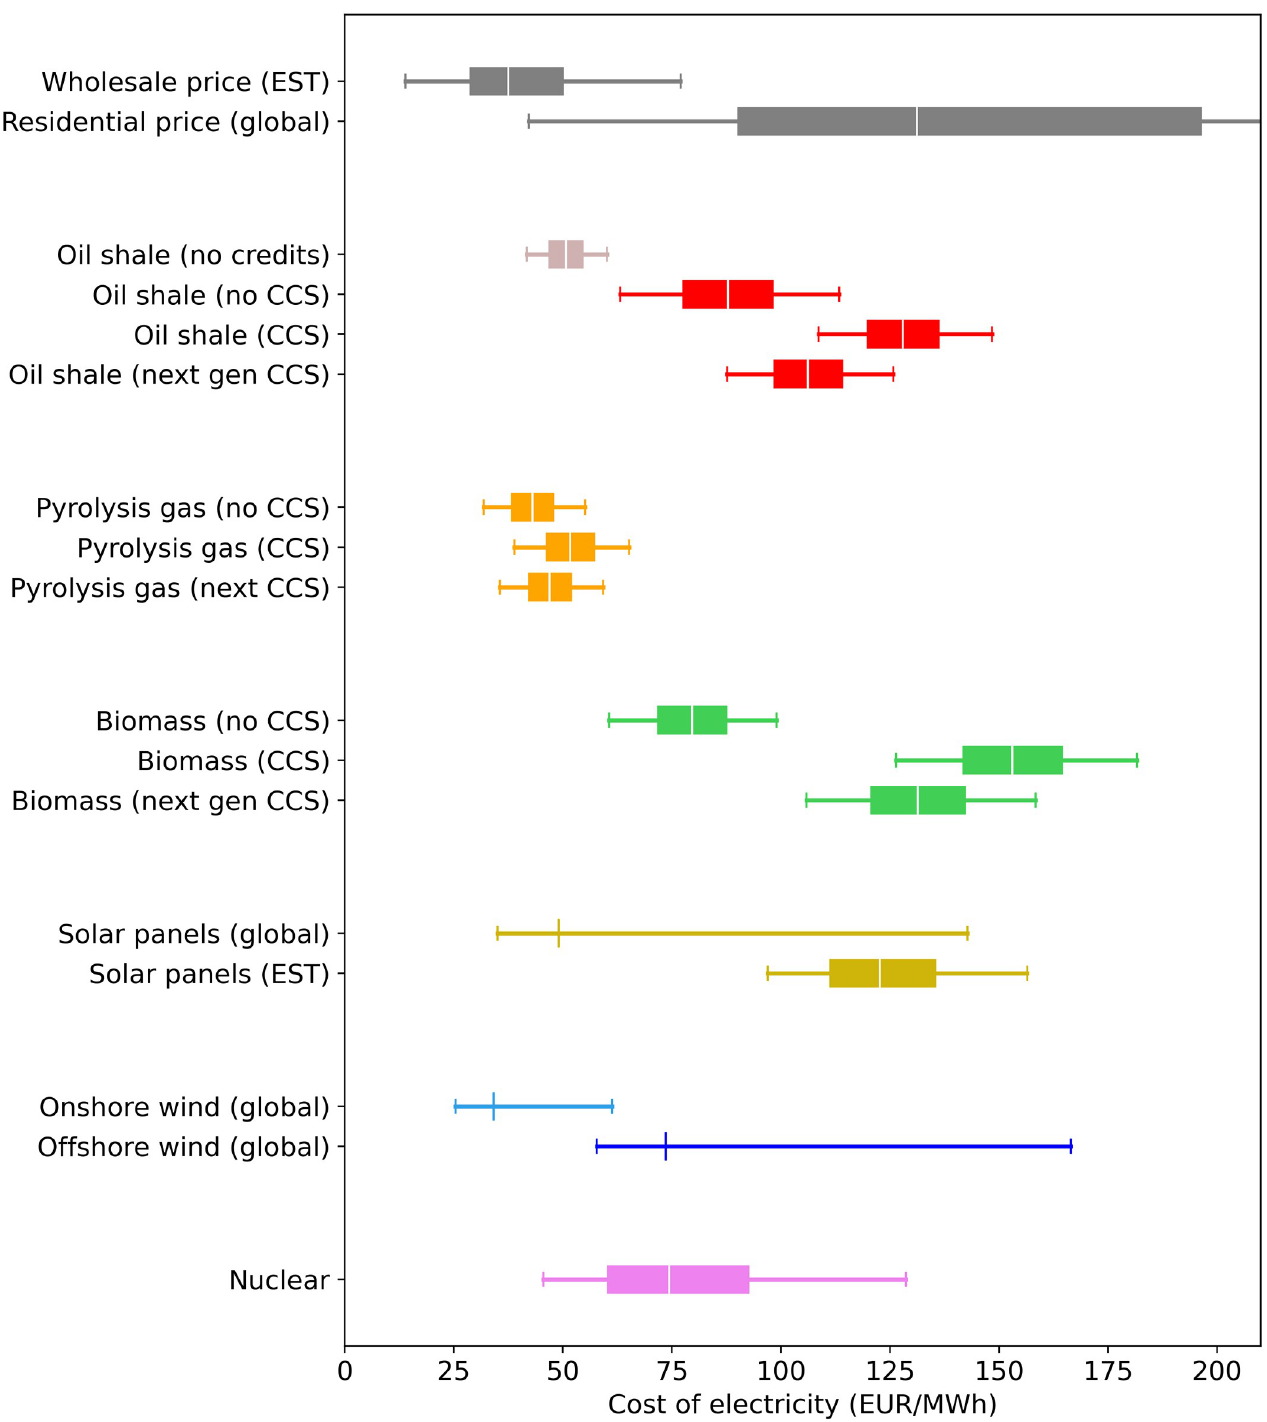
Fig 3. Comparison of the cost of various electricity production technologies. Global costs for solar and wind were taken from ref [5], and the average line for those is the global weighted average. The global residential price data is from [138].